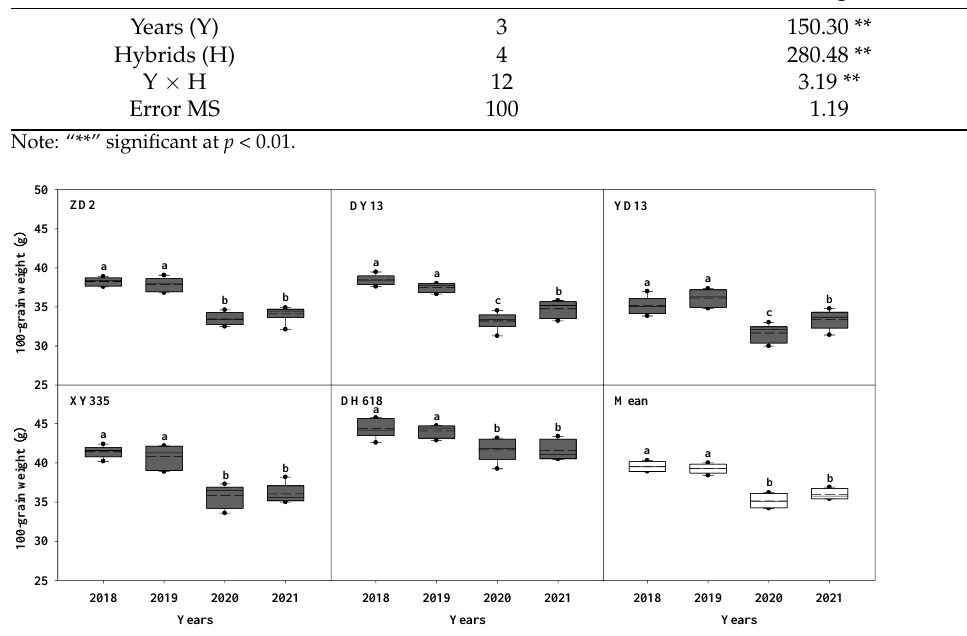
Figure 2. The difference of the 100-grain weight of maize hybrids in different years. Note: In the boxplot, the solid line represents the median, the dotted line represents the average, and the top and bottom of the box represent the upper and lower quartiles. Different letters indicate significant difference ( p < 0.05). 3.2. Variation of Grain Nutritional Quality of Maize under Different Meteorological Elements ANOVA and LSD test results indicated that the crude protein content, total starch content, and crude fat content of grains were significantly different among years, hybrids, and year × hybrids ( p < 0.01) (Table 3). As shown in Figure 3, the average crude protein content in grains of the five hybrids was the highest in 2018, which was significantly in- creased by 5.41%, 12.09%, and 4.95% compared with that in 2019 – 2021 ( p < 0.05). In 2018 and 2020, the grain crude protein content of DY13 was the highest among hybrids, the grain crude protein content of YD13 was the highest among hybrids in 2019, and the grain crude protein content of ZD2 was the highest among hybrids in 2021. The mean value of total starch content in grains of the five cultivars in 2020 was the highest, significantly increasing by 0.92%, 0.56%, and 0.50% compared with 2018, 2019, and 2021 ( p < 0.05), re- spectively. The total starch content among hybrids was the highest in DH618. The range of total starch content among hybrids was significantly different in different years, with the most significant difference between hybrids in 2018 and 2021. The average crude fat